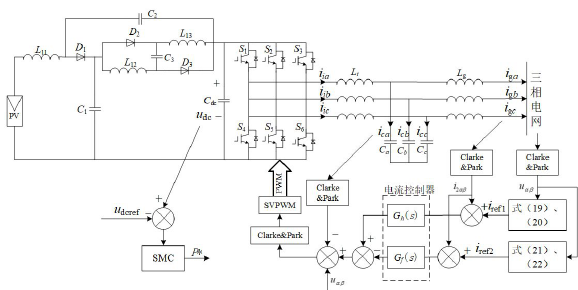
Fig. 2. Overall control block diagram of Quasi-Z inverter grid connected